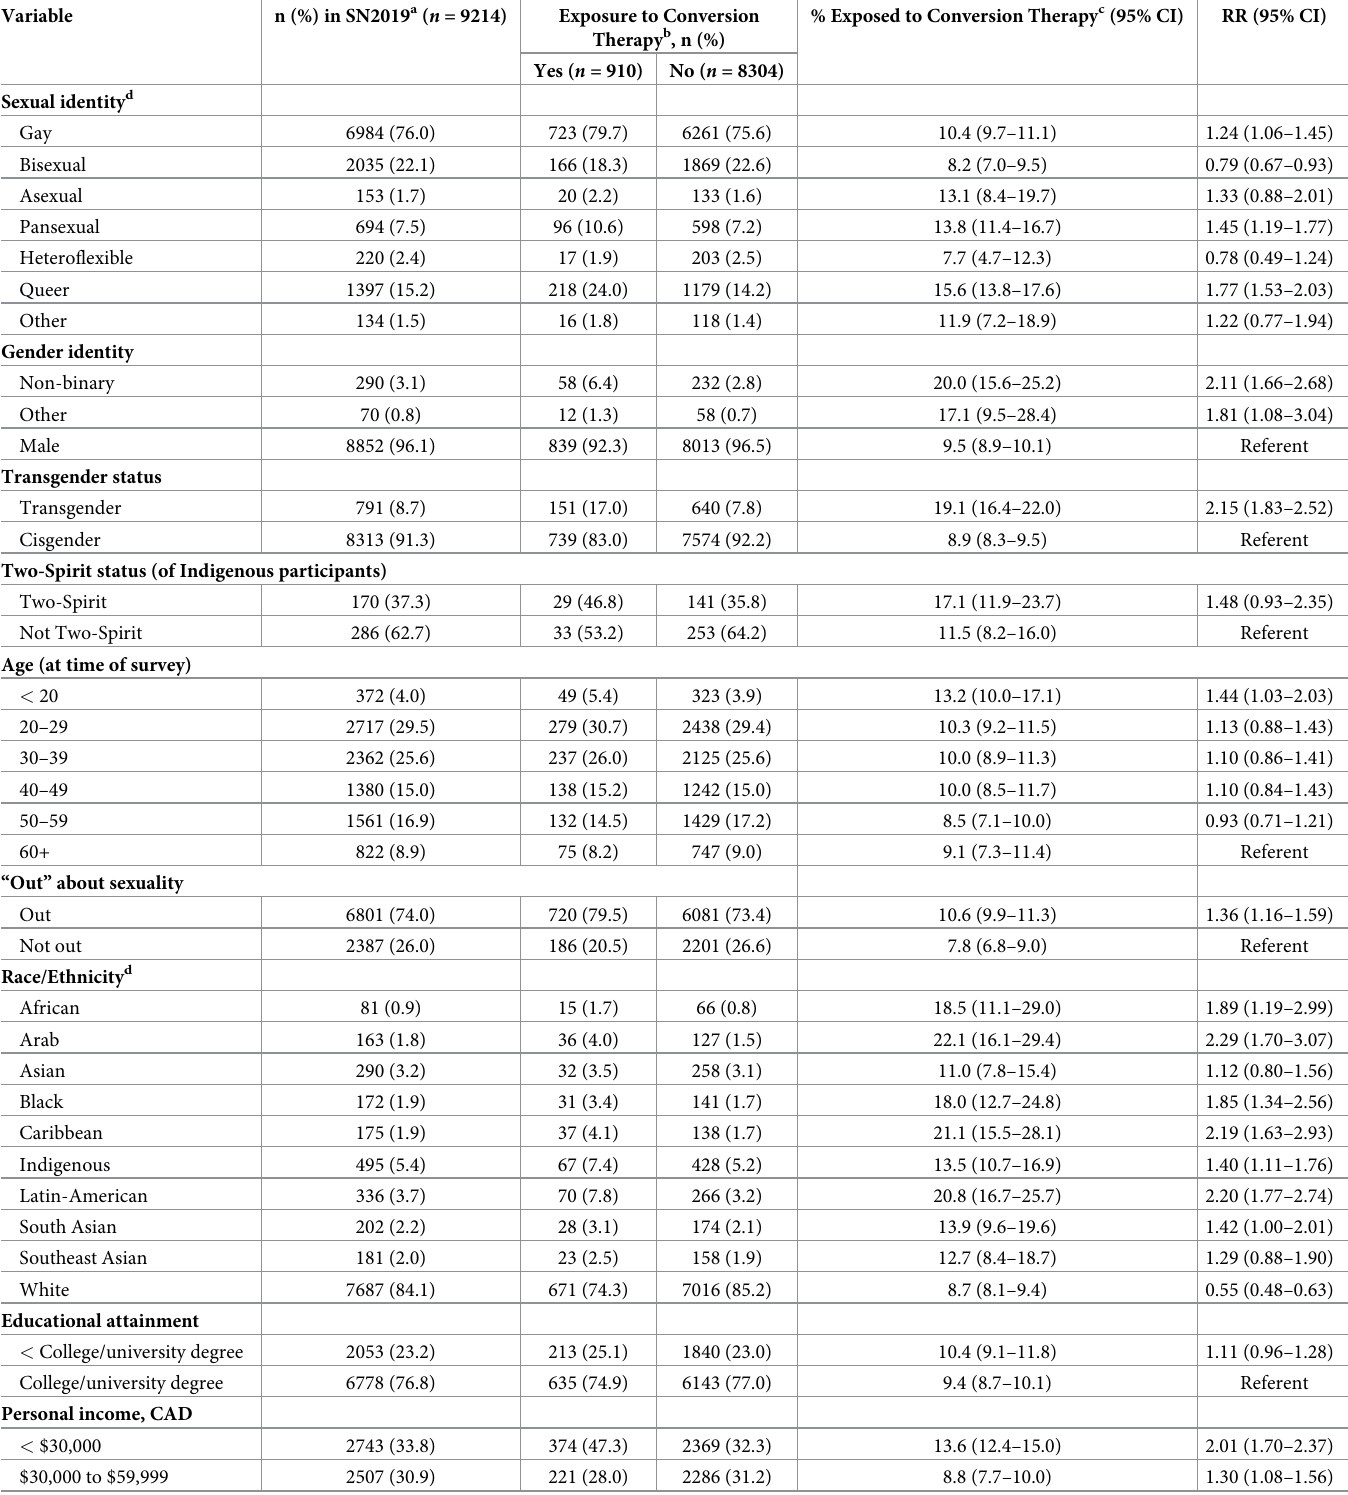
Table 1. Lifetime prevalence of exposure to conversion therapy among sexual and gender minority Canadian men, by sociodemographic subgroups,